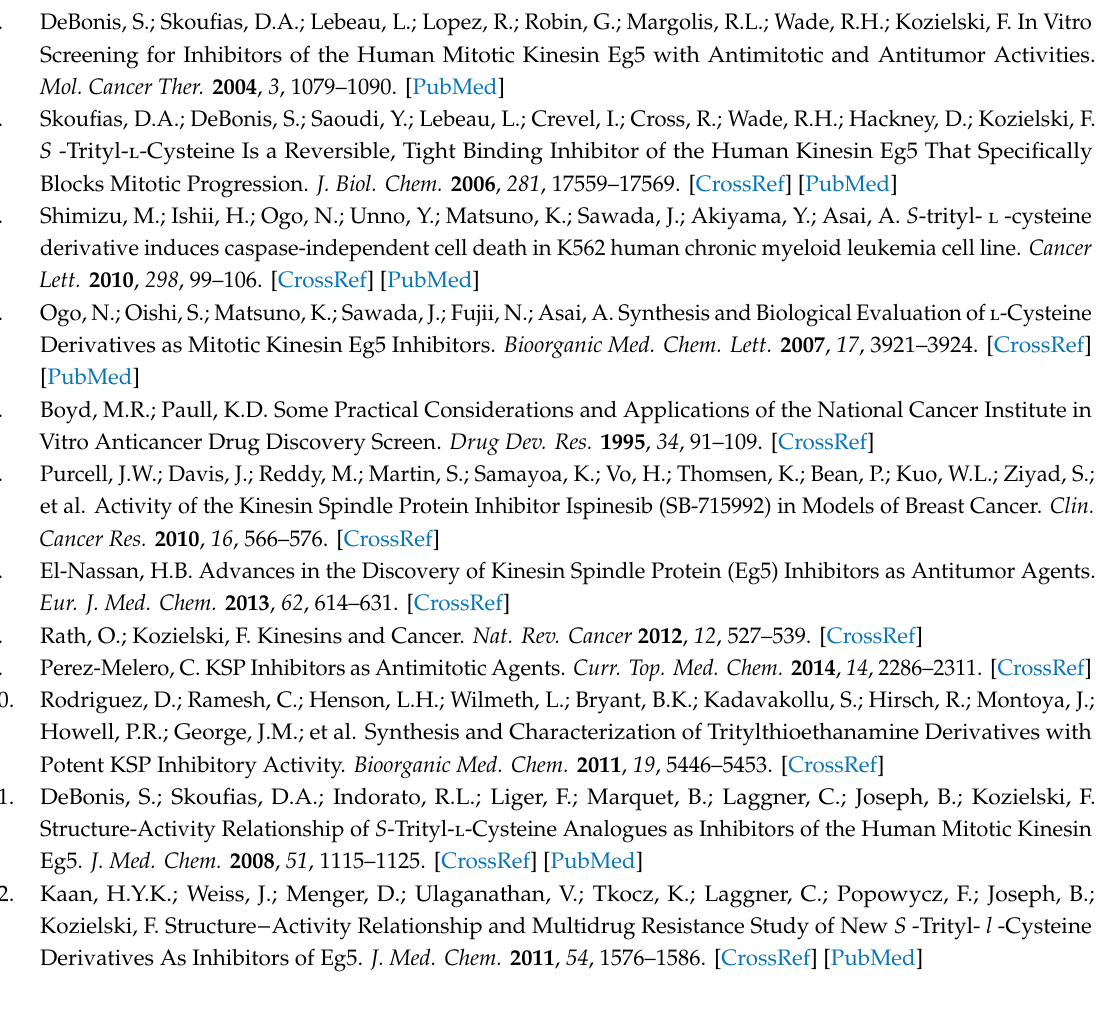
Figure S1: 1 H-NMR of compound 1; Figure S2: 1 H and 13 C NMR of STC1 ; Figure S3: 1 H- and 13 C-NMR of STC2; Figure S4: 1 H- and 13 C-NMR of STC3; Figure S5: 1 H- and 13 C-NMR of STC4; Figure S6: 1 H- and 13 C-NMR of STC5; Figure S7: 1 H- and 13 C-NMR of STC6; Figure S8: 1 H- and 13 C-NMR of STC7; Figure S9: 1 H- and 13 C-NMR of STC8; Figure S10: 1 H- and 13 C-NMR of STC9; Figure S11: 1 H-NMR of compound 2; Figure S12: 1 H- and 13 C-NMR of STC10; Figure S13: 1 H- and 13 C-NMR of